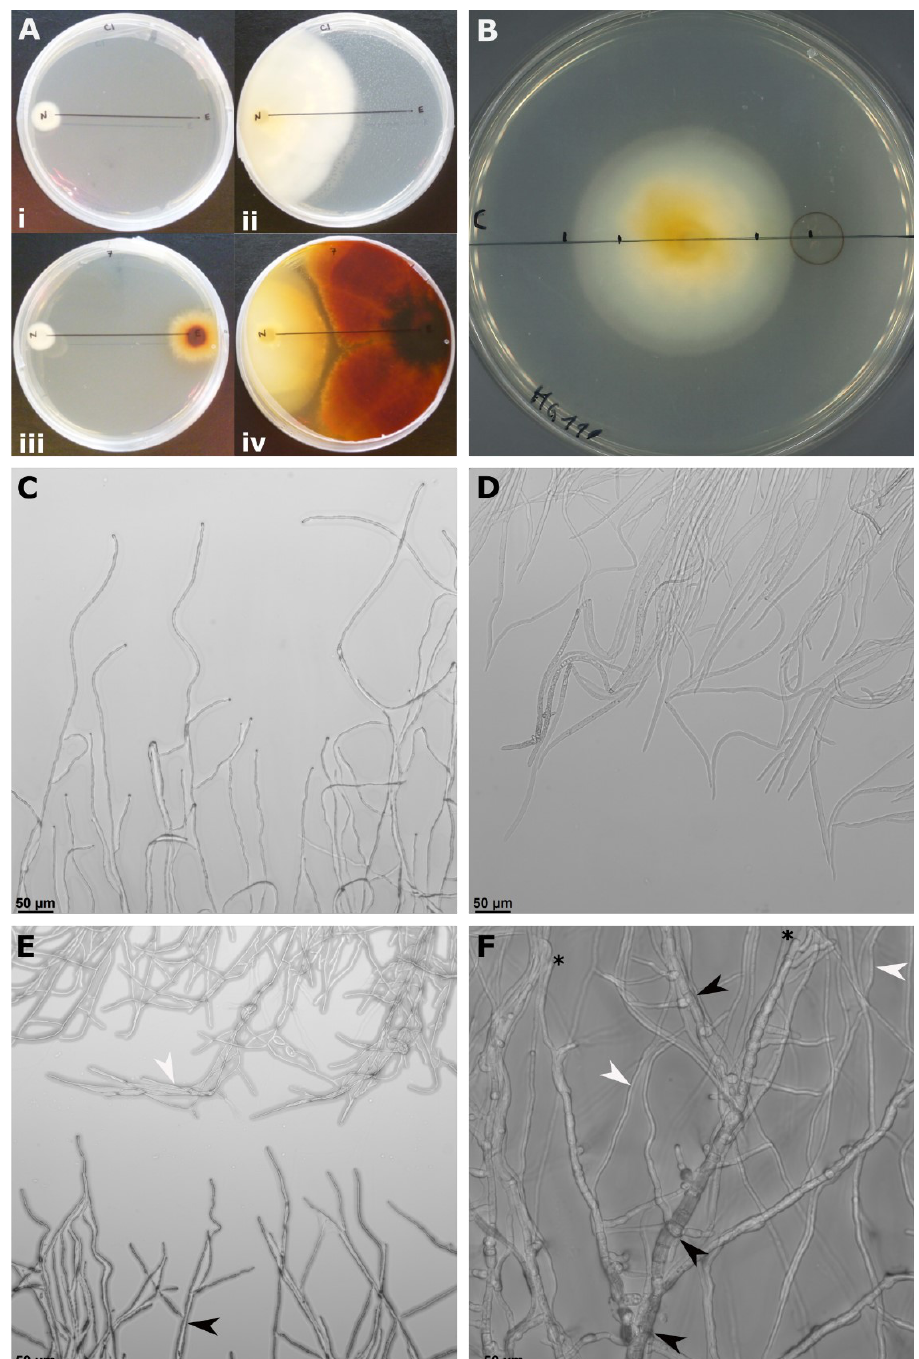
Figure 2. In vitro biocontrol assays. Co-culture assay ( A ) showing N. ditissima control plates ( i , ii ) and B14-1 co-culture test plates ( iii , iv ) at 3 ( i , iii ) and 14 days ( ii , iv ) after assay set up. Soluble metabolite assay ( B ) with DMSO control on the left-hand side (labelled as “C”) and B14-1 extract on the right-hand side of the panel. Microscopy observation of co-culture plates ( C – F ). Morphology of B14-1 ( C ) and N. ditissima ( D ) hyphae when grown in isolation. On co-culture plates N. ditissima hyphae ( E , white arrow) were observed growing at an almost 90° angle to B14-1 hyphae ( E , black arrow) immediately before contact with B14-1. Upon contact, the tips of B14-1 hyphae became bulbous, thickened, and increased branching ( F , black arrows). N. ditissima hyphae ( F , white arrows) did not change morphology upon contact. The tips of B14-1 hyphae in panel F are denoted with *.